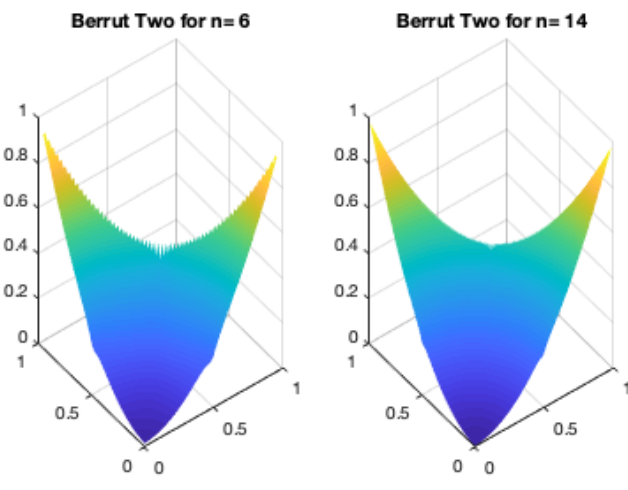
Figure 12. Berrut Two for n even but n /2 odd and f ( x , y ) = x 2 + y 2